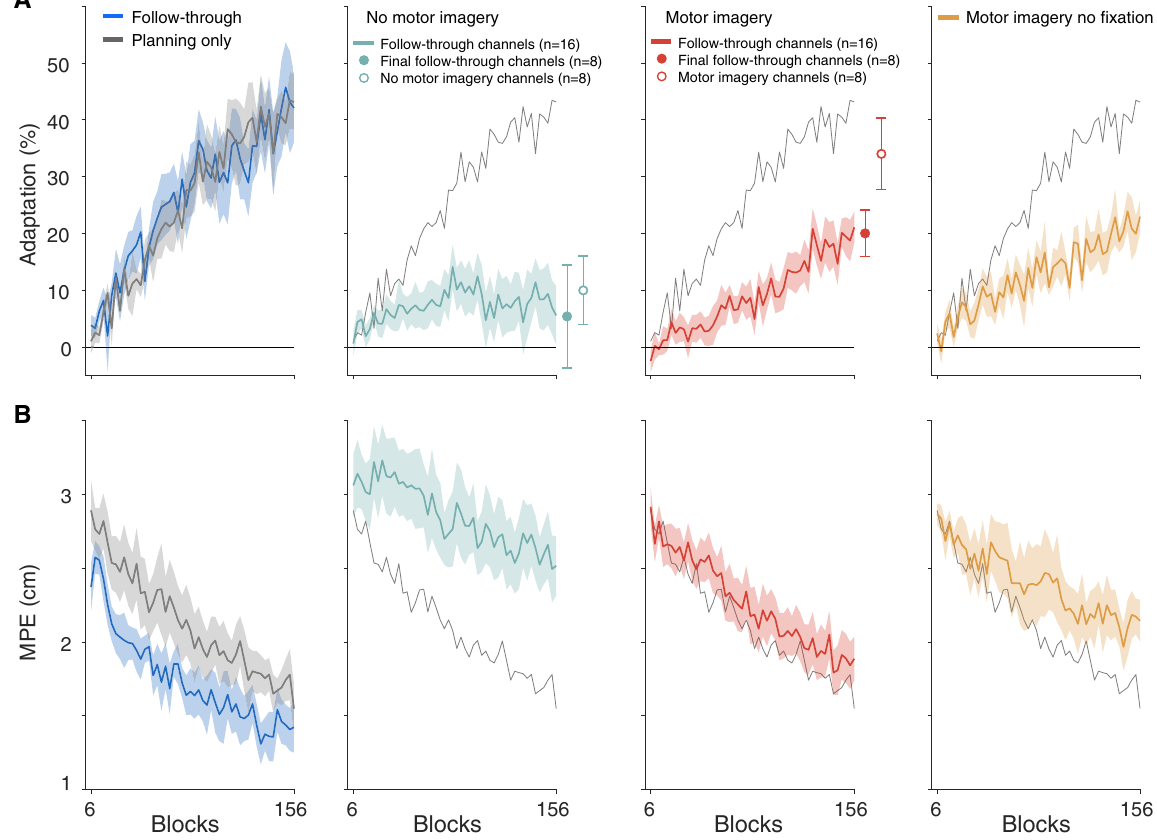
Figure 2. Motor imagery of follow-through leads to adaptation. ( A ) Adaptation in the exposure phase, measured on channel trials which were full follow through movements in all groups (Fig. 1B, left). The solid circles to the right of the imagery and no-imagery learning curves are the final adaptation on full follow- through channel trials of the participants who subsequently performed the probe phase (half the subjects). The unfilled circles show the adaptation measured on motor imagery- or no-motor imagery channel trials (Fig. 1B, middle and right) in the same subjects as the solid circles. ( B ) Maximum perpendicular error (MPE) measured on exposure trials. Data show mean ± s.e. across participants (for display the 150 exposure blocks were averaged over consecutive blocks of 3 to produce 50 bins) in the exposure phase. For comparison, the mean adaptation and MPE for the planning only group (grey) are repeated on all